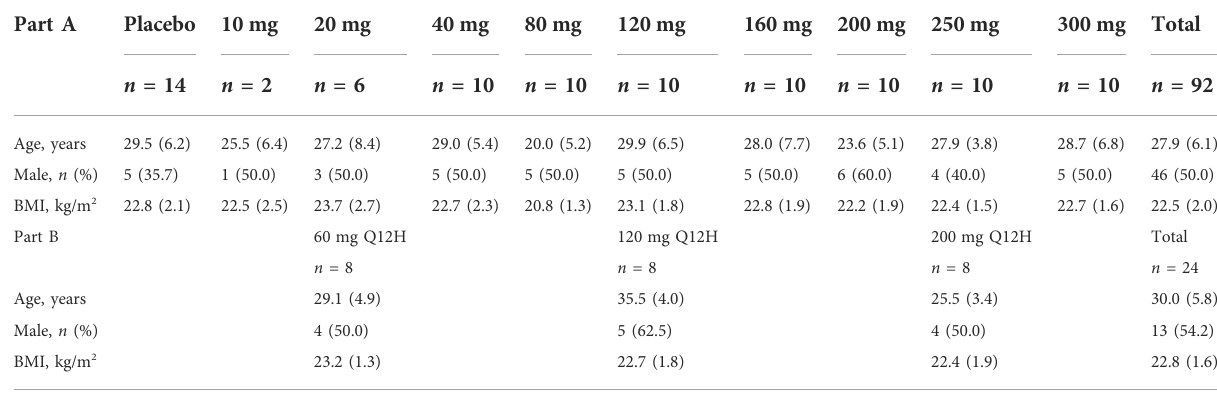
FIGURE 1 Mean (±SD) plasma concentration – time pro fi les, following the single ascending dose of SAA in healthy Chinese subjects. SAA, salvianolic acid